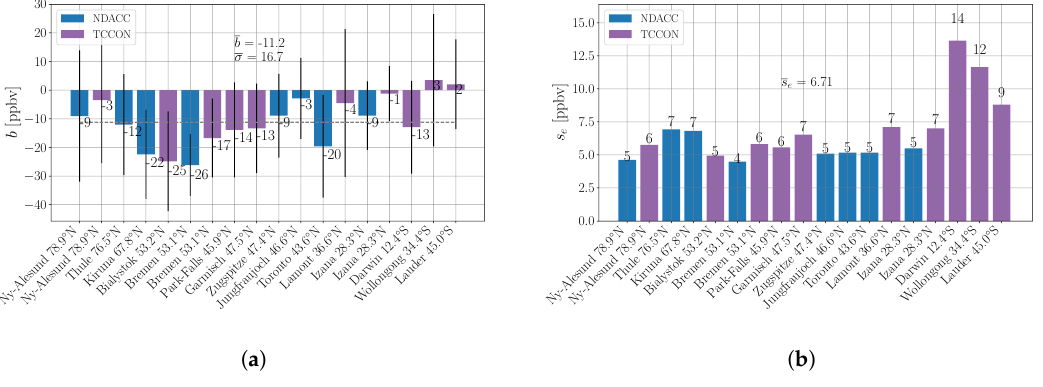
Figure 8. Mean bias, standard deviation, and standard error as in Figure 7 but with monthly-mean averages of SCIAMACHY CO weighted according to the inverse distance from the reference site. ( a ) Global monthly-mean bias b and respective standard error σ ; ( b ) The global standard error of the mean biases s e is the average of all standard errors of the